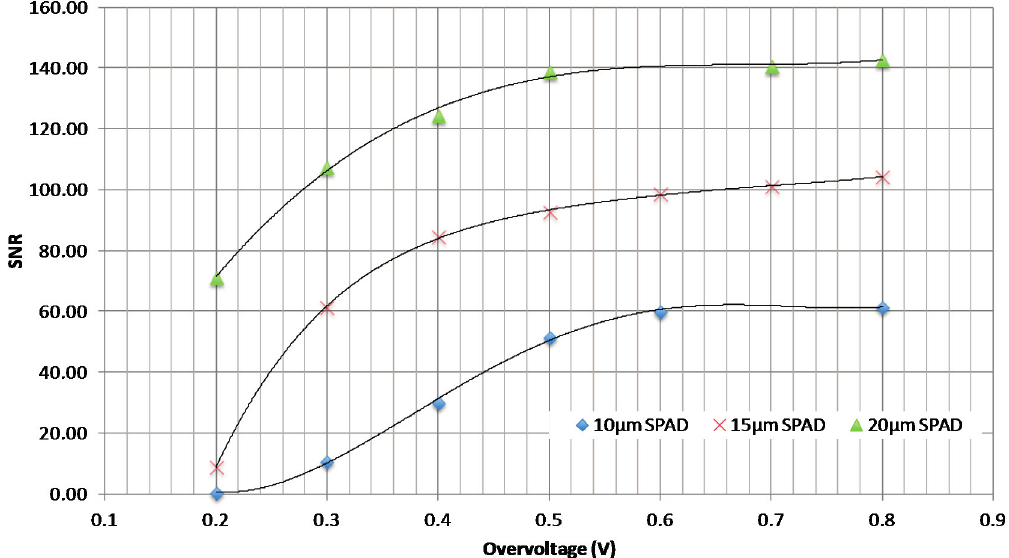
Figure 9. SNR as a function of